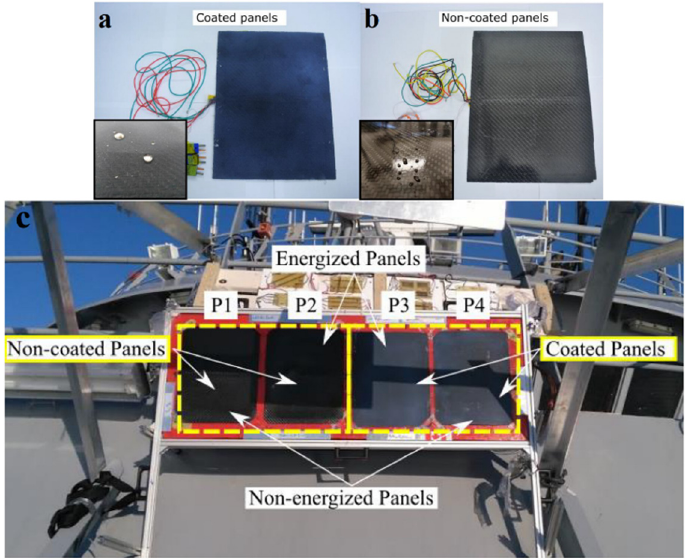
Figure 16. ( a ) Panel with a hydrophobic coating presenting water droplets protruding from the surface; ( b ) an uncoated panel demonstrating that water droplets slightly wet the surface; ( c ) pho- tographs of different panels installed on board the ship. Reprinted with permission from [84].